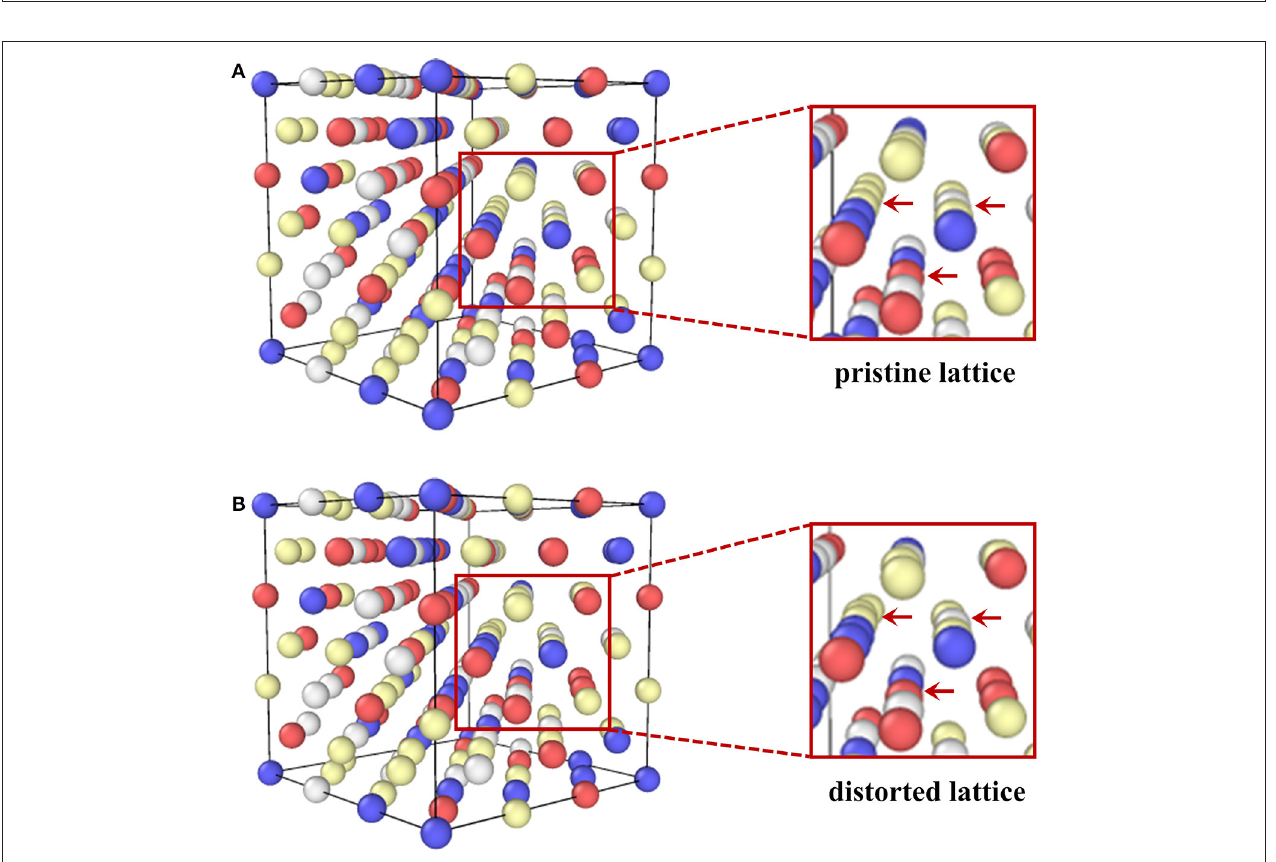
FIGURE 6 | The DFT simulation results of (A) the pristine lattice with an ideal FCC structure and (B) the distorted lattice of the CoCrFeNi